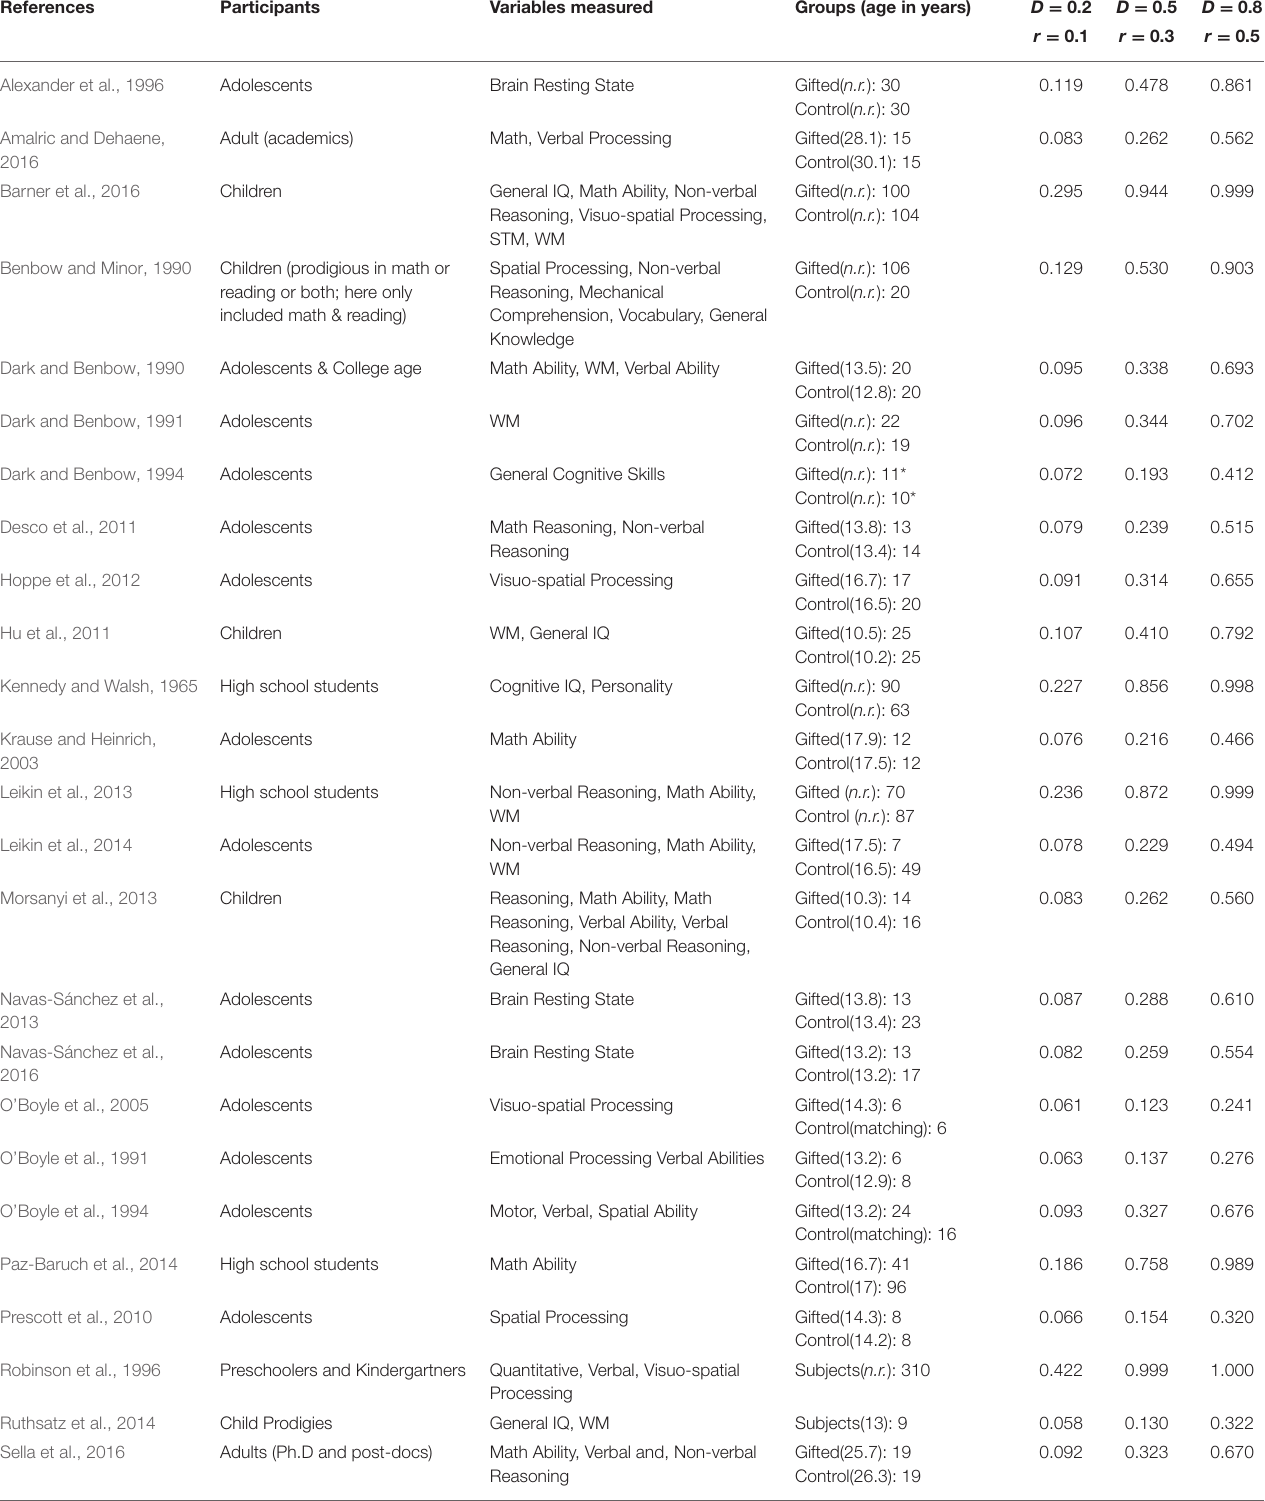
TABLE 2 | The power of studies comparing mathematical gifted and control individuals to detect small ( D = 0.3 or r = 0.1), medium ( D = 0.5 or r = 0.3), and large ( D = 0.8; or r = 0.5)